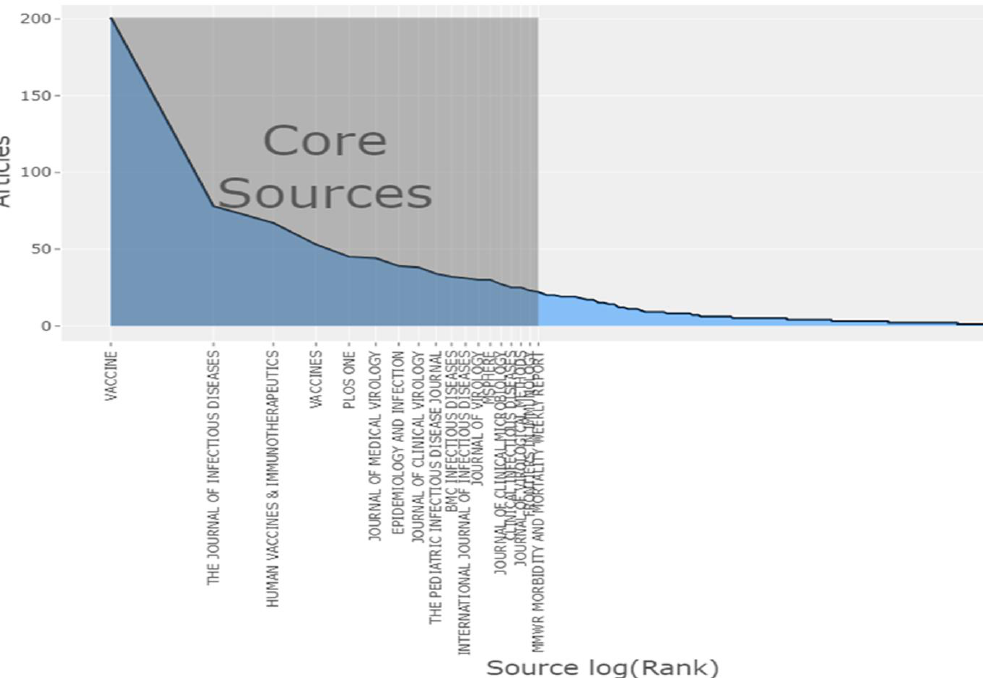
with 15,341 citations, and the number of core + zone 2 sources was 1675 with 29,473 cita- tions, as shown in Figure 3.